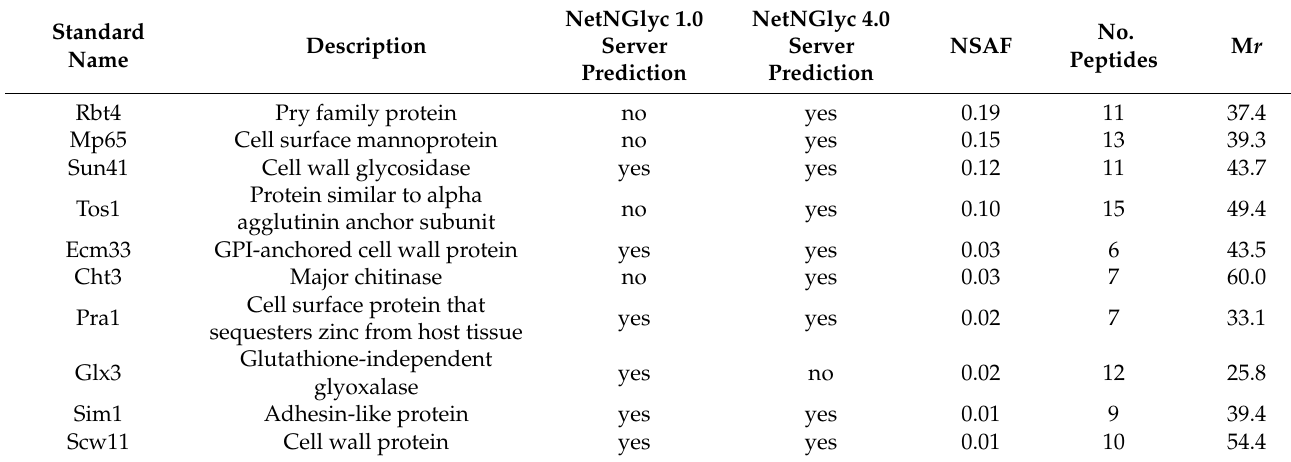
Table 3. The more abundant proteins identified by LC-MS/MS in the left upper corner of a preparative 2-DE gel of the C. albicans hyphal secretome (NSAF higher than